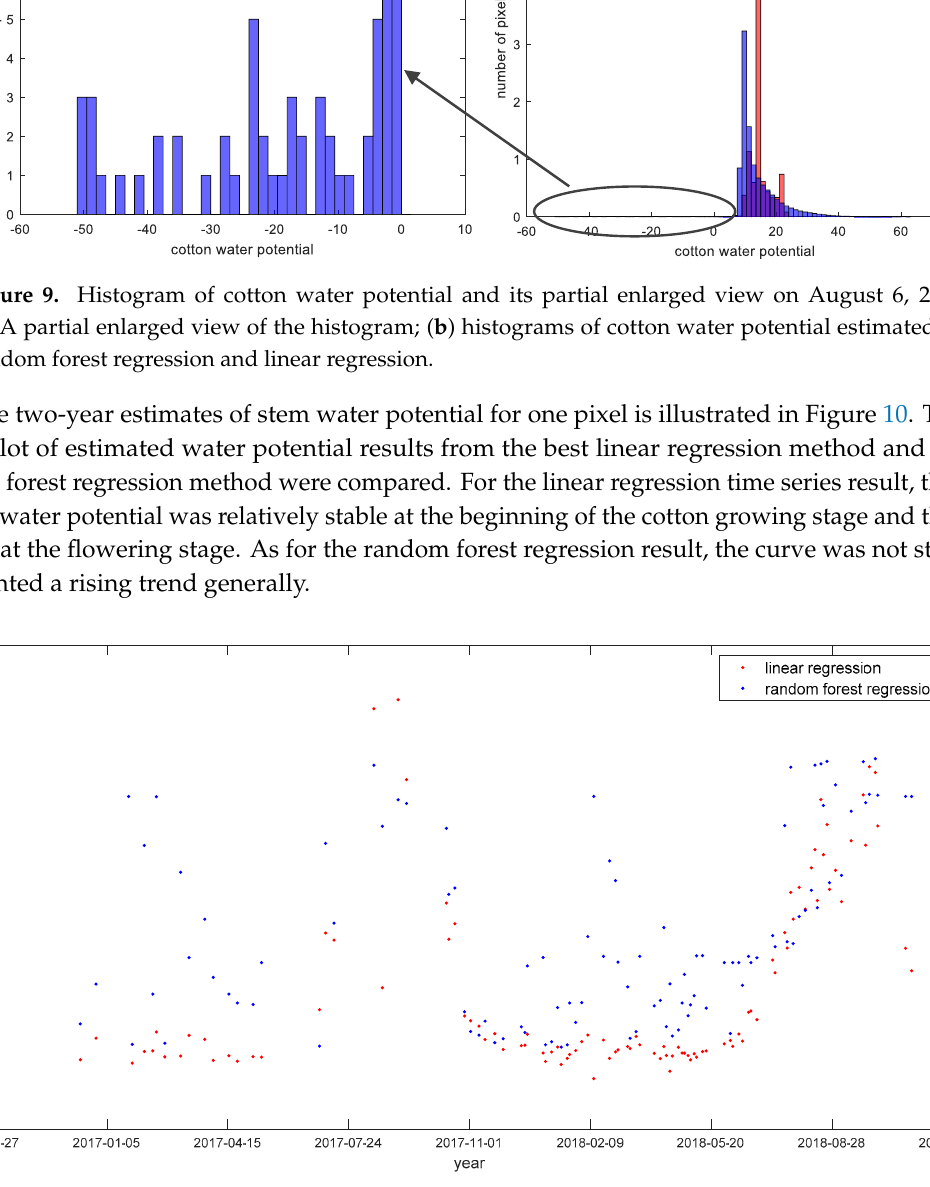
Figure 8. Continuous monitoring of stem water potential based on ( a ) random forest regression method and ( b ) linear regression method. The 2018 Crop Data Layer (CDL) was employed to mask out non-cotton areas (grey color).